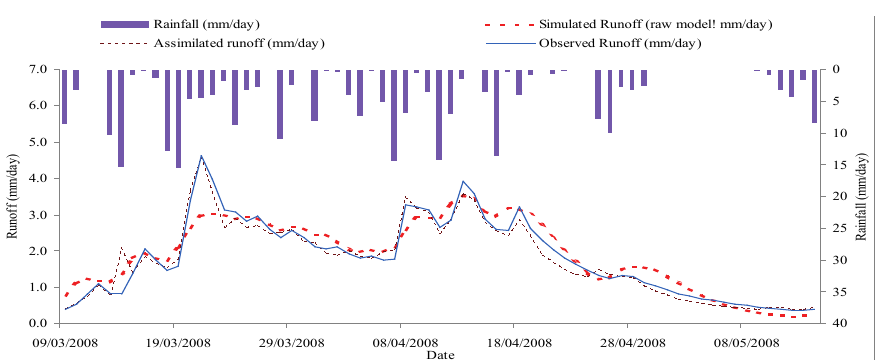
Fig. 4 Evolution of streamflow predicted (fine dished line) compared to those obtained with HBV simulation (bold dished line) and observed stream flow (continuous line) at the outlet of the Serein for the observed period 9 March 2008–14 May 2008, with 3 days assimilation and 1 day forecast lead time. SW , STW1 , STW2 and STW3 are updated with assimilation. HBV without assimilation Nash = 0.87, Assimilated flow Nash = 0.95.